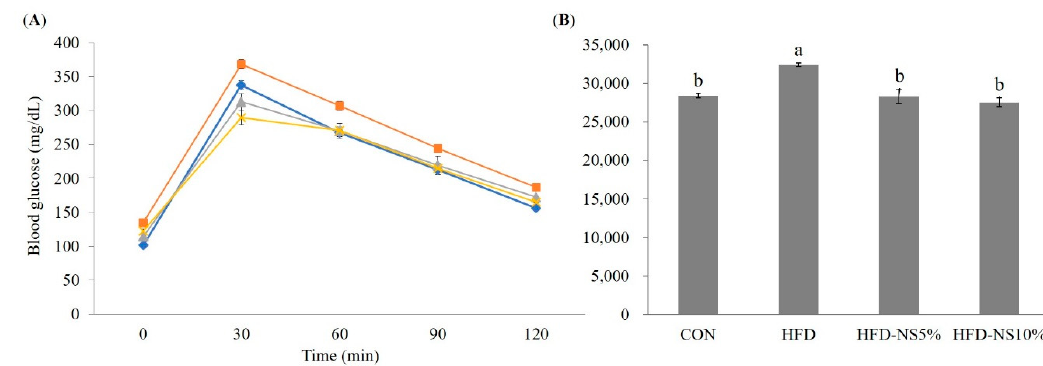
Figure 4. Effect of Nelumbinis Semen powder, normal diet, and high-fat diet on intraperitoneal glucose tolerance test (IPGTT) in C57BL/6 mice administered a high-fat diet with low- or high-dose Nelumbinis Semen powder (5% and 10%, respectively). ( A ) Effect of Nelumbinis Semen powder on IPGTT , CON, control group; , HFD, high-fat diet; , HFD-NS5%, high-fat diet with 5% Nelumbinis Semen powder; , HFD-NS10%, high-fat diet with 10% Nelumbinis Semen powder. ( B ) Effect of Nelumbinis Semen powder on the area under the curve of IPGTT. Values are the mean ± SE ( n = 8/group). a, b The different letters represent significant differences at p < 0.05 by Duncan’s multiple range test.